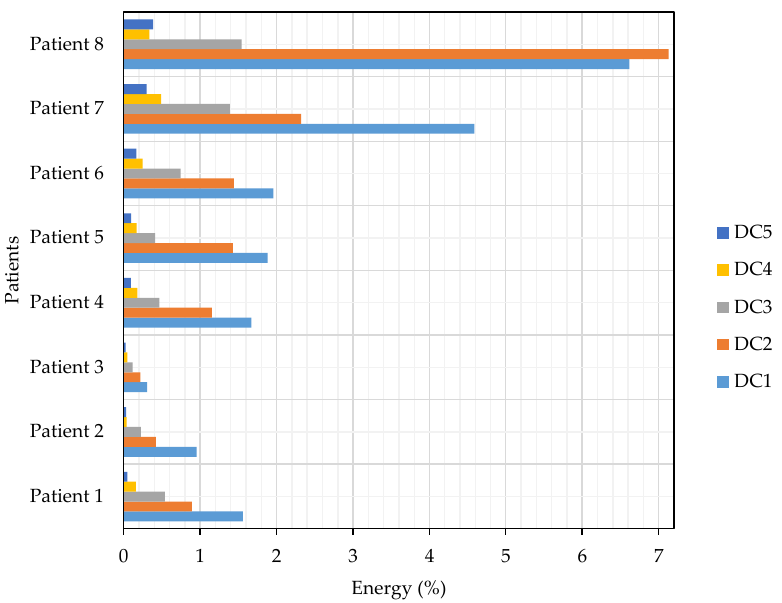
Figure 9. Percentage distribution of energy in the subbands of the coefficients.